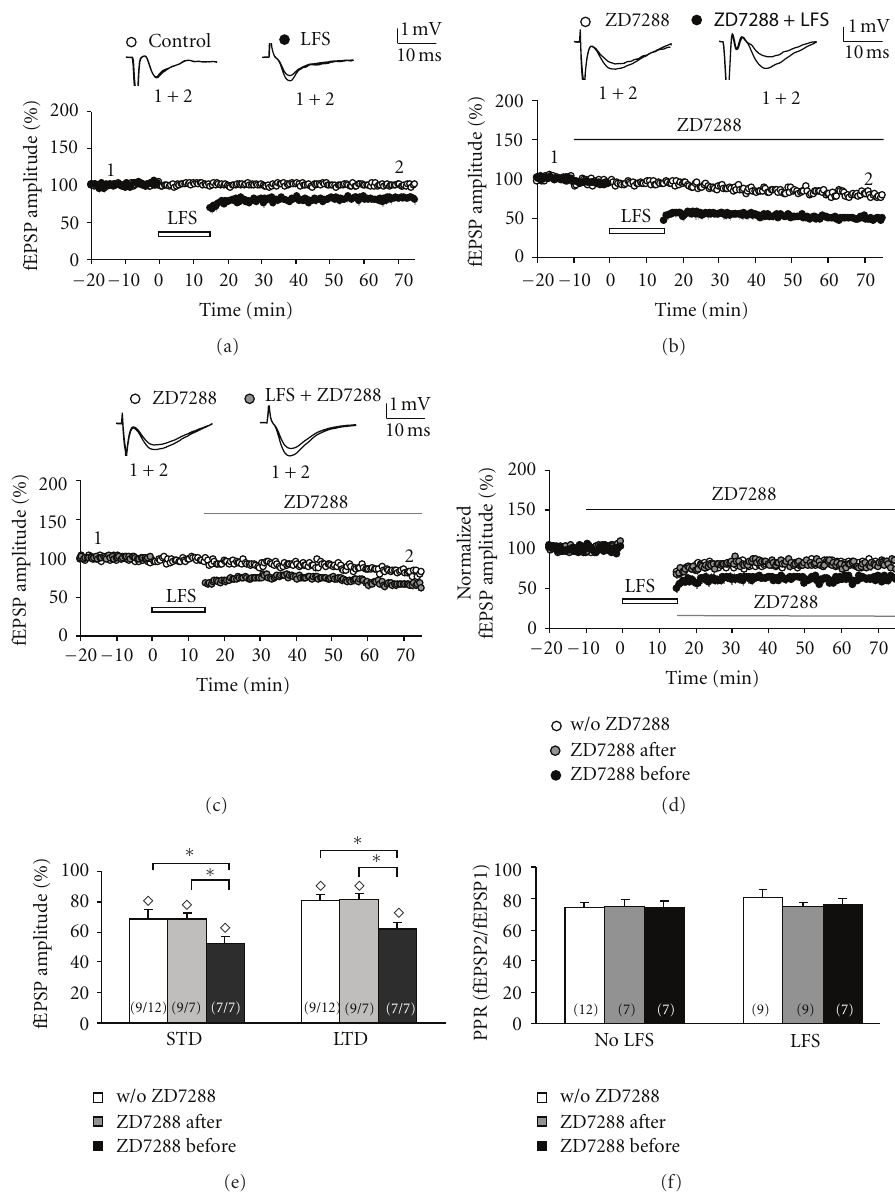
Figure 1: ZD7288 enhances LFS-induced LTD in early postnatal rats. (a) The time course of the excitatory postsynaptic field potential (fEPSP) amplitude following stimulation of the medial perforant path (MPP) in early postnatal rats (P9–15) displays LTD (closed symbols) following low-frequency stimulation (LFS, indicated by an open bar). Time-control experiments without LFS (open symbols) confirmed stable recording conditions. Representative fEPSPs were taken at the beginning (indicated by “1”) and at the end (indicated by “2”) of the experiment. (b) The time course of the fEPSP amplitude following ZD7288 treatment (starting 10min prior to LFS, indicated by a closed bar) shows an enhanced depression in LFS-treated slices (closed symbols). Non-LFS-treated time-control experiments (open symbols) showed a synaptic depression after ZD7288 application. Note the large di ff erence of fEPSP amplitudes at the end of the experiment which was more pronounced than that without ZD7288 application in (a). (c) Comparing the fEPSP amplitude time course following ZD7288 treatment (starting after LFS, indicated by a gray bar) between LFS-treated (gray symbols) and non-LFS-treated time-control experiments (open symbols) reveals a synaptic depression which was similar to that in non-ZD7288 conditions shown in (a). (d) Normalized time courses of fEPSP amplitudes in three di ff erent conditions: without ZD7288 (open symbols), ZD7288 before LFS (closed symbols), and ZD7288 after LFS (gray symbols). Note that similar levels of LFS-induced STD and LTD were obtained in both slices without ZD7288 and slices with ZD7288 after LFS. (e) The bar graph summarizes the STD and LTD levels of three di ff erent conditions. The number of slices is given in parentheses (number of LFS-treated slices/number of non-LFS-treated slices). (f) The bar graph summarizes the paired-pulse ratio of all experimental groups recorded at the beginning of each experiment, that is, before ZD7288 and/or LFS were applied to the slices. Note that the PPR was similar in all groups. All data are mean ±